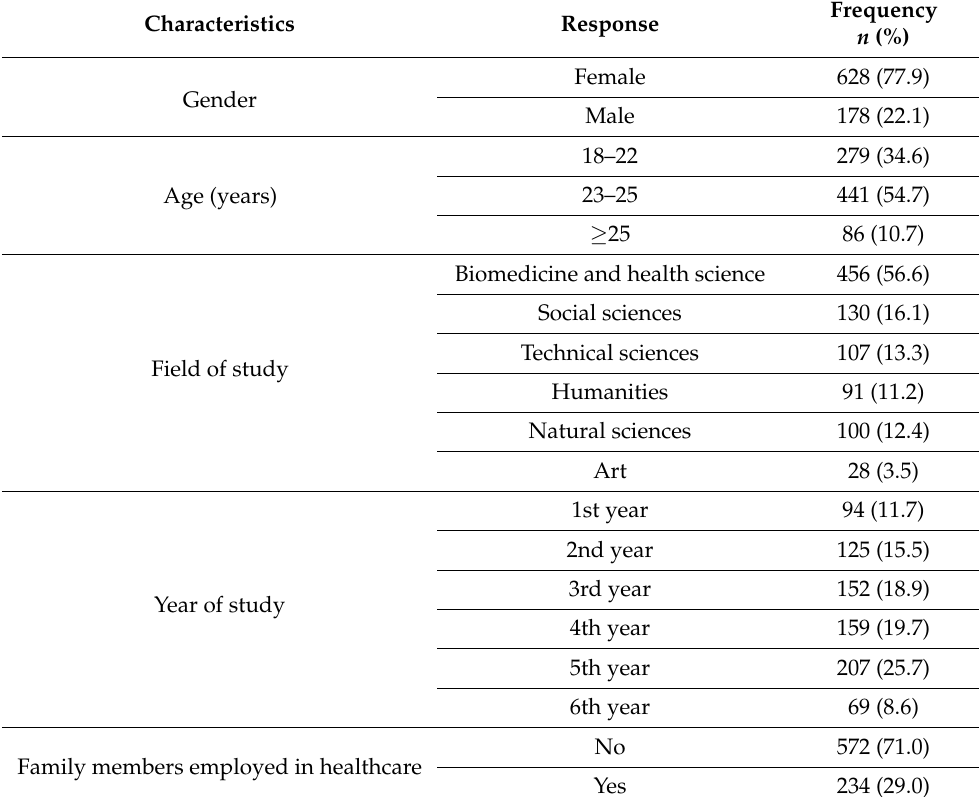
Table 1. Demographic characteristics of respondents ( n =